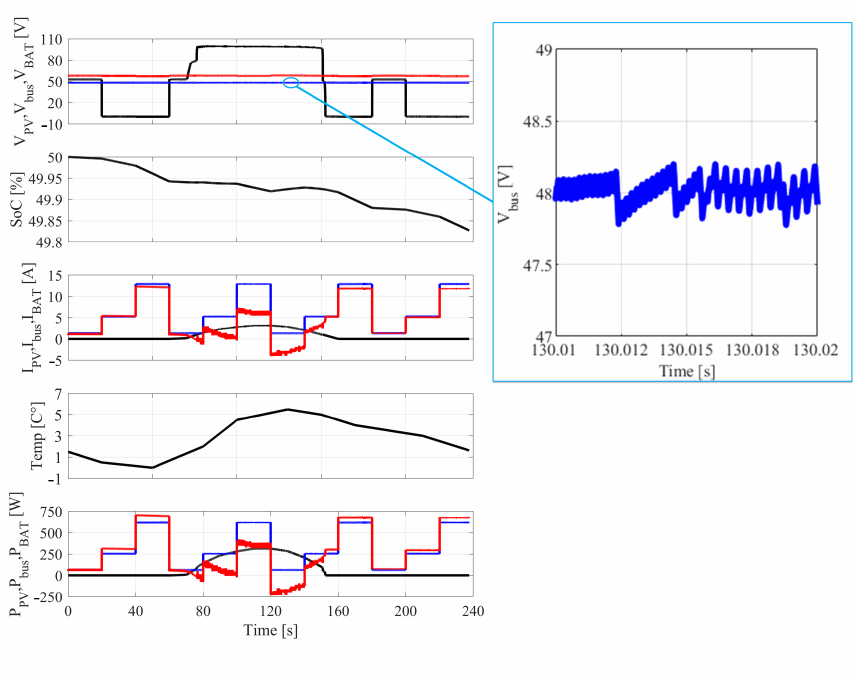
Figure 23. Simulation results in winter standard conditions for Parma, 44 ◦ 45 (cid:48) 53 (cid:48)(cid:48) N 10 ◦ 18 (cid:48) 26 (cid:48)(cid:48) E, Italy. V PV , I PV , P PV (black), V bus , I bus , P bus (blue), V BAT , I BAT , P BAT (red), SoC, Temperature. In the inset it is magnified a part of the DC bus voltage